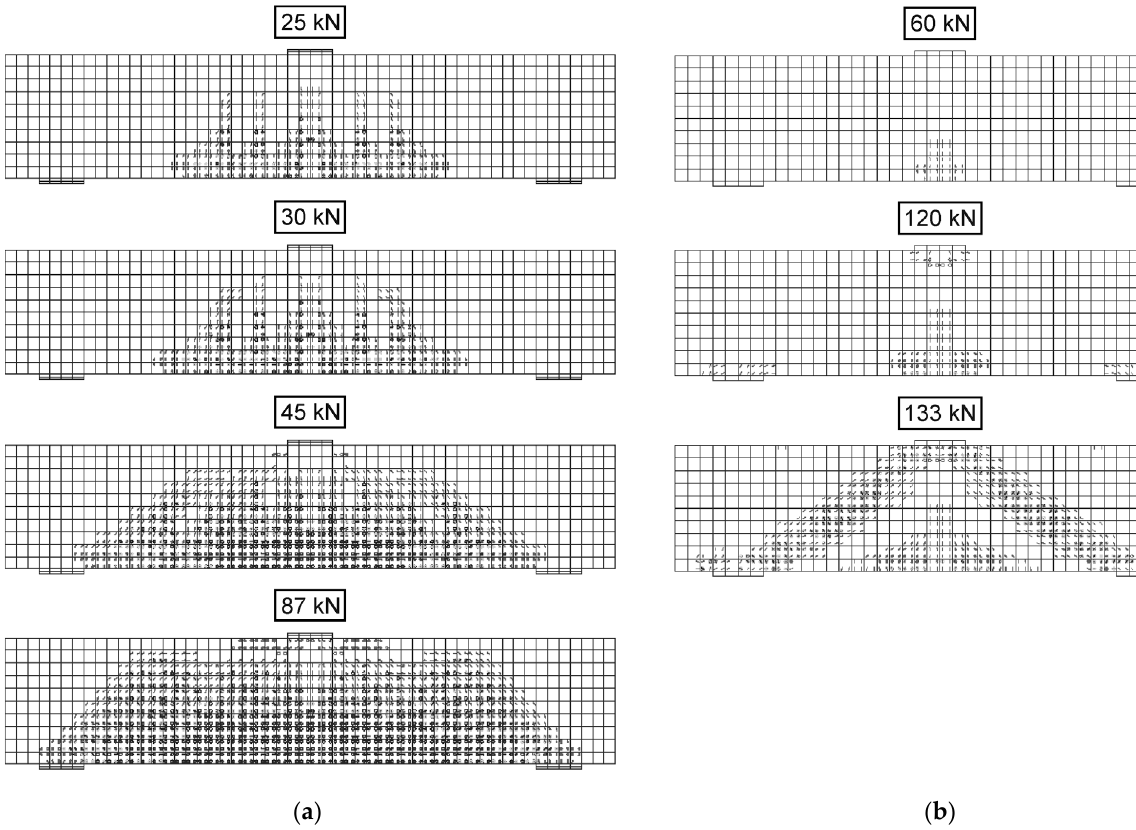
Figure 13. Smeared cracks for the beams ( a ) slender beam PII-3 ( a/d = 2.5, ρ = 0.9%, f y = 548 MPa); ( b ) short beam PII-1 ( a/d = 1.8, ρ = 0.9%, f y = 548 MPa).